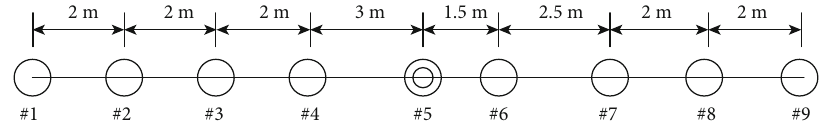
Figure 3: Schematic diagram of the boreholes. Table 1: Parameters for the THM coupling